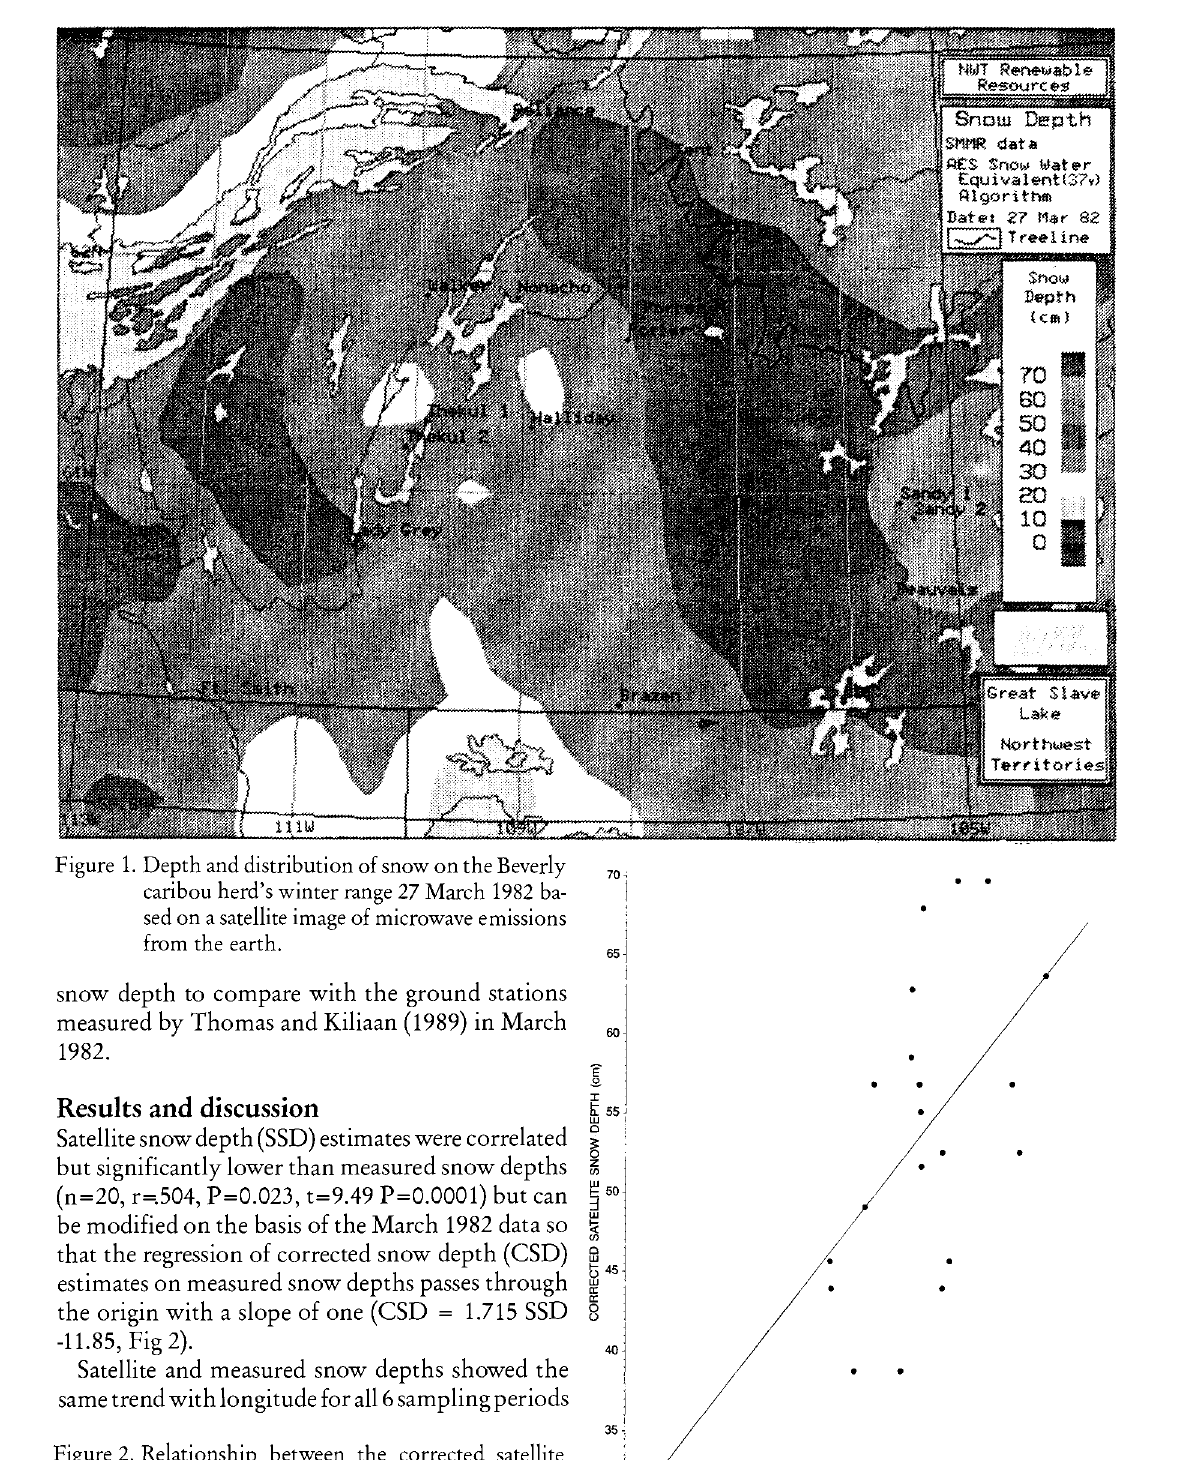
Figure 1. Depth and distribution of snow on the Beverly caribou herd's winter range 27 March 1982 ba sed on a satellite image of microwave emissions from the